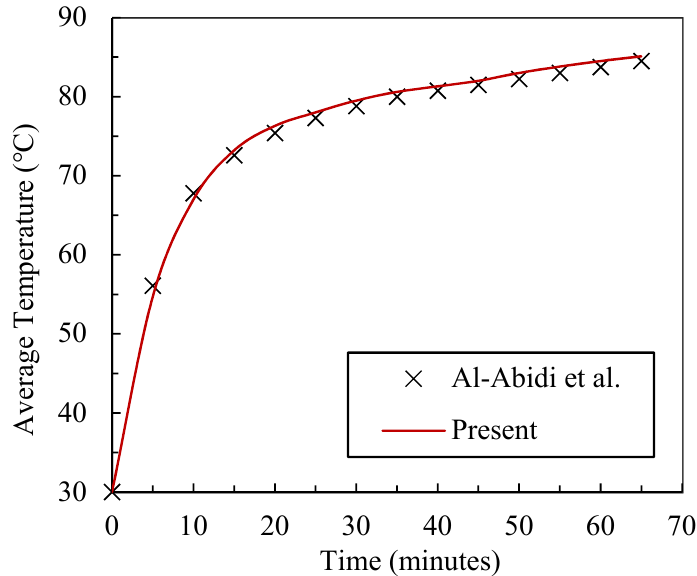
Figure 3. Validation of the numerical method against the experimental results reported by Al-Abidi et al. [31].